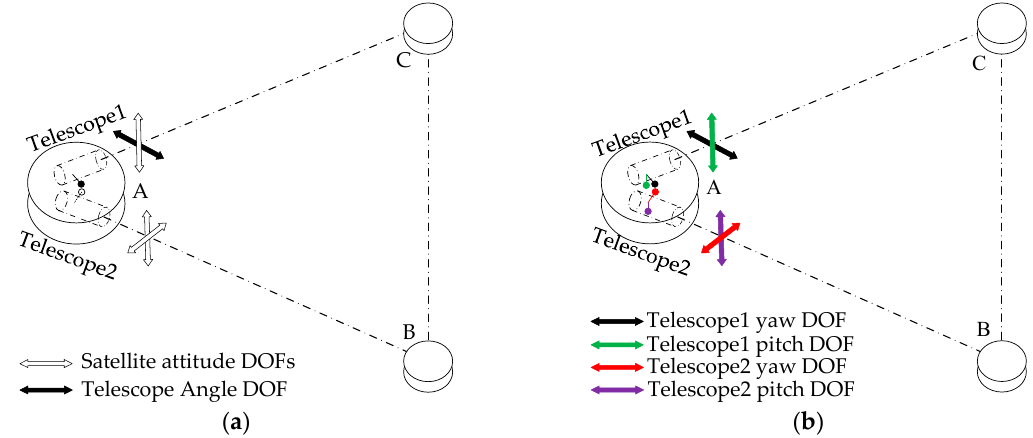
Figure 2. Control of the telescope pointing DOFs. ( a ) Three attitude DOFs and one telescope DOF; ( b ) Each telescope has two DOFs.